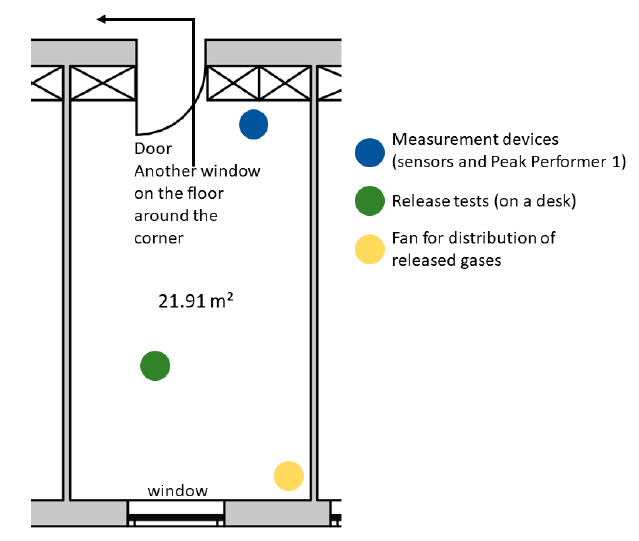
Figure 1. Field test room and positions of the measurement devices, release tests, and a fan for improved distribution of the evaporated substances inside the room .